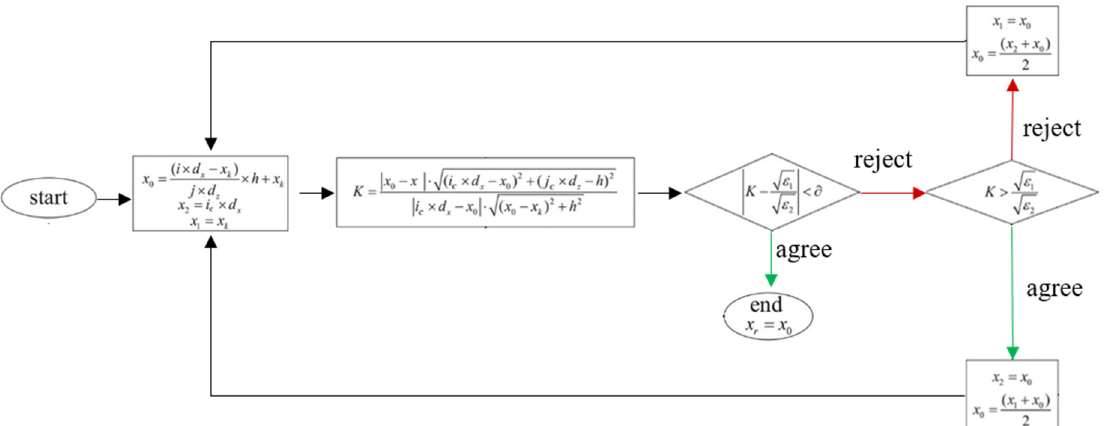
Figure 7. A successive-approximation algorithm calculates the position of the refraction point. xr is the horizontal position of the refraction point. In addition, the ∂ is a minuscule value, which defines the method’s accuracy.